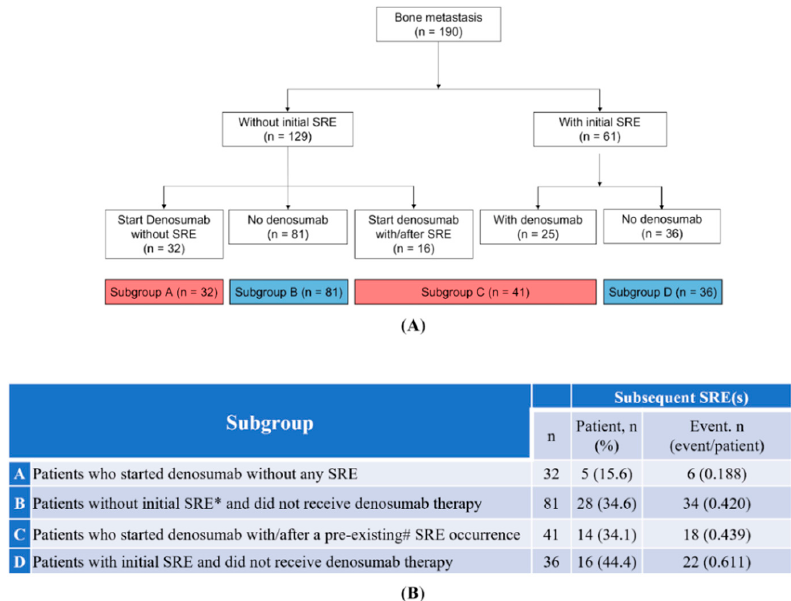
Figure 1. ( A ) Subgroups of EGFR -mutated NSCLC patients with bone metastasis, and ( B ) subsequent SRE(s) occurrence in different subgroups of EGFR -mutated NSCLC patients with bone metastasis. * Initial SRE: SRE occurring at the time of initial diagnosis of NSCLC concomitant with bone metasta- sis. # Pre-existing SRE: the SRE leading to initiation of denosumab. EGFR : epidermal growth factor receptor; NSCLC: non-small cell lung cancer; SRE: skeletal-related